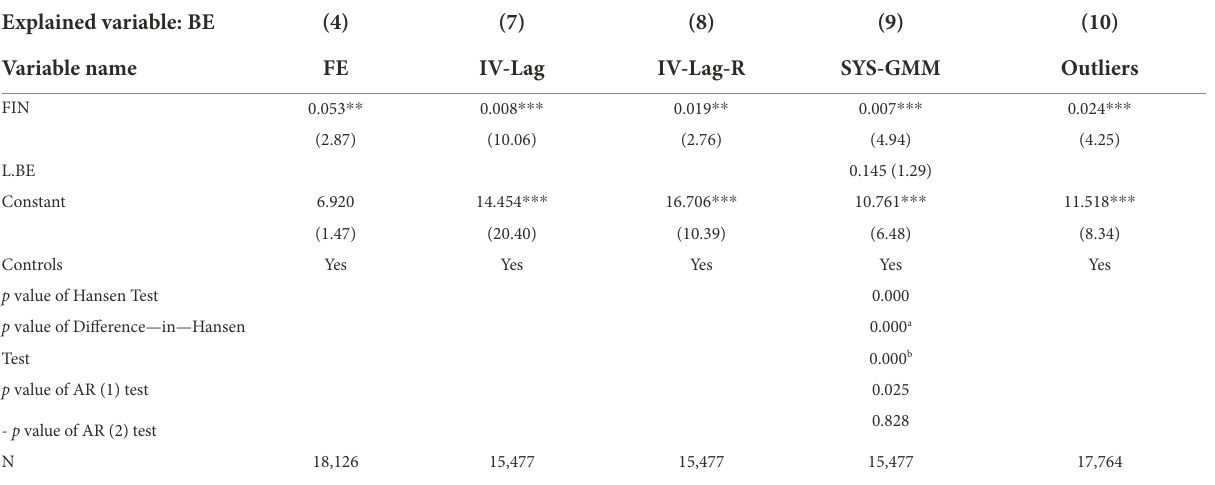
TABLE 5 Robustness